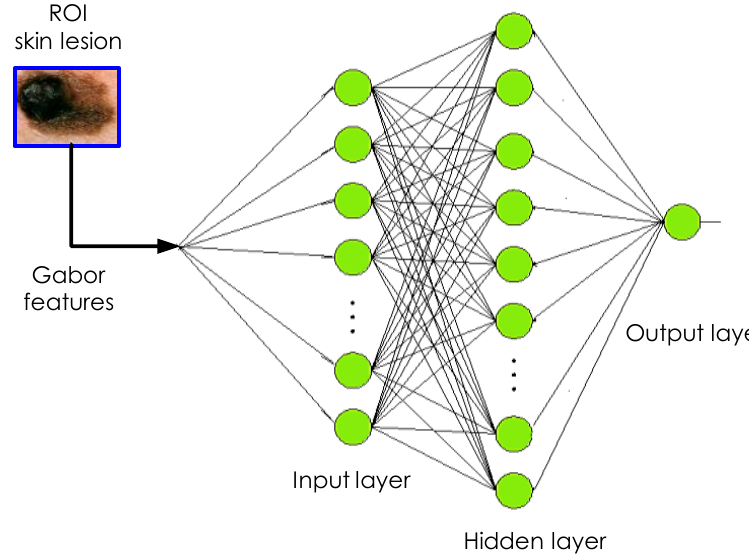
Figure 8. The MNN structure established for melanoma